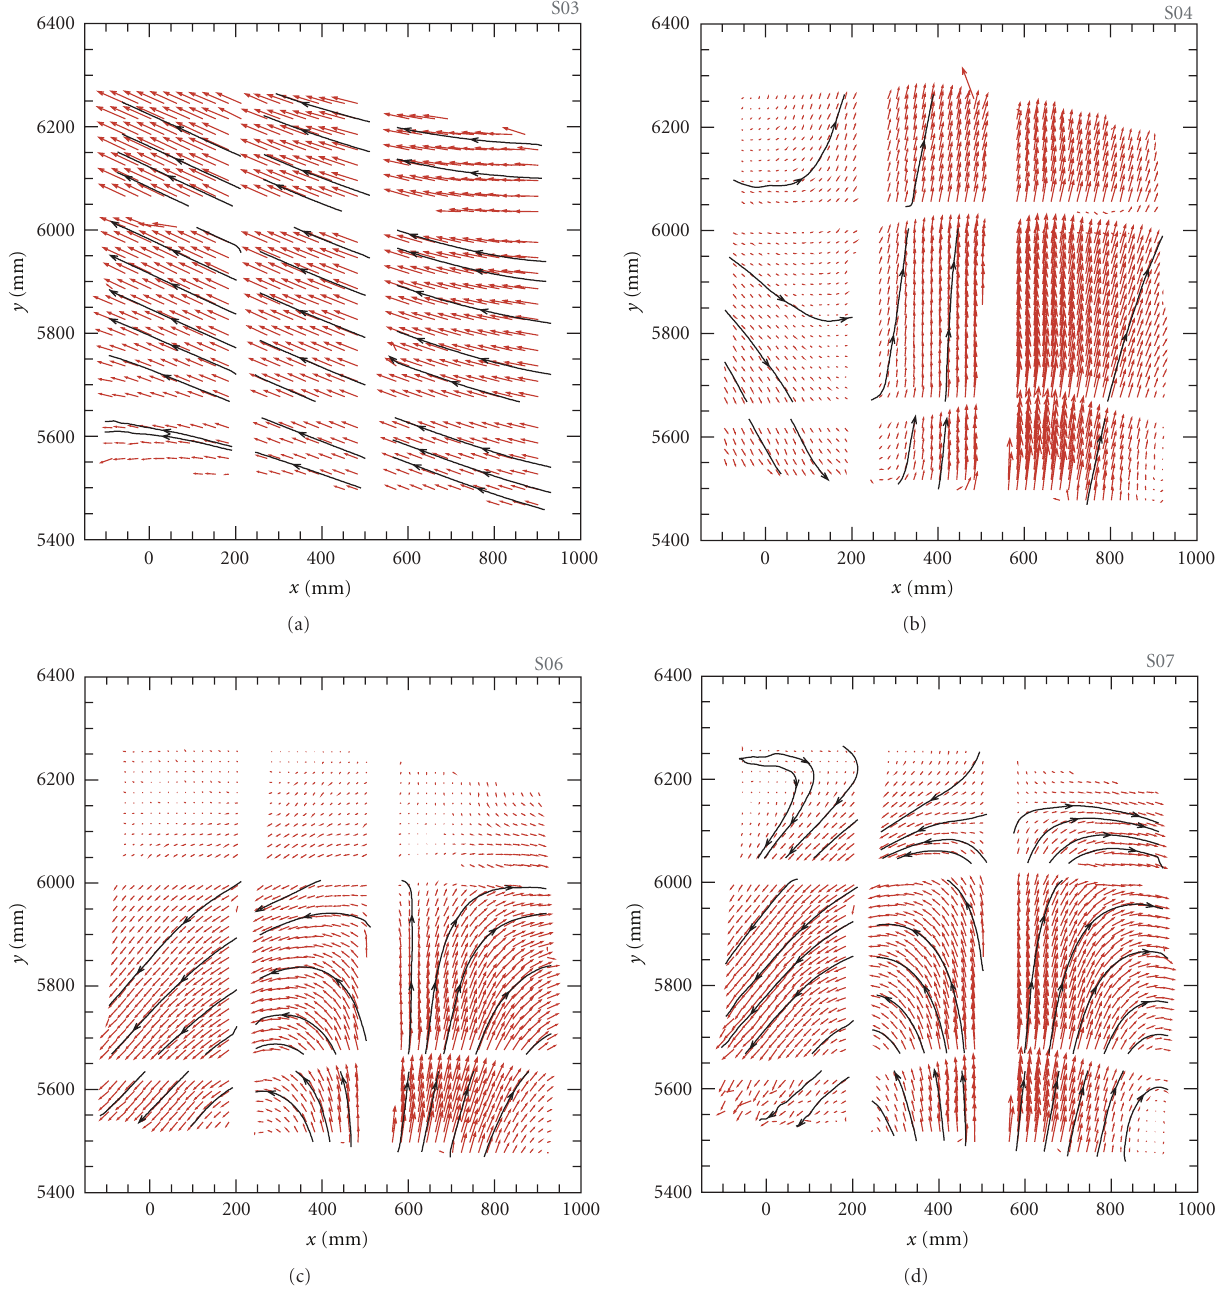
Figure 10: Selected mean velocity fields for ST4 2( 2) for (a) 3541 s < t < 3746 s, (b) 5384 s < t < 5896 s, (c) 7135 s < t < 7340 s, and (d) 7517 s < t < 8541